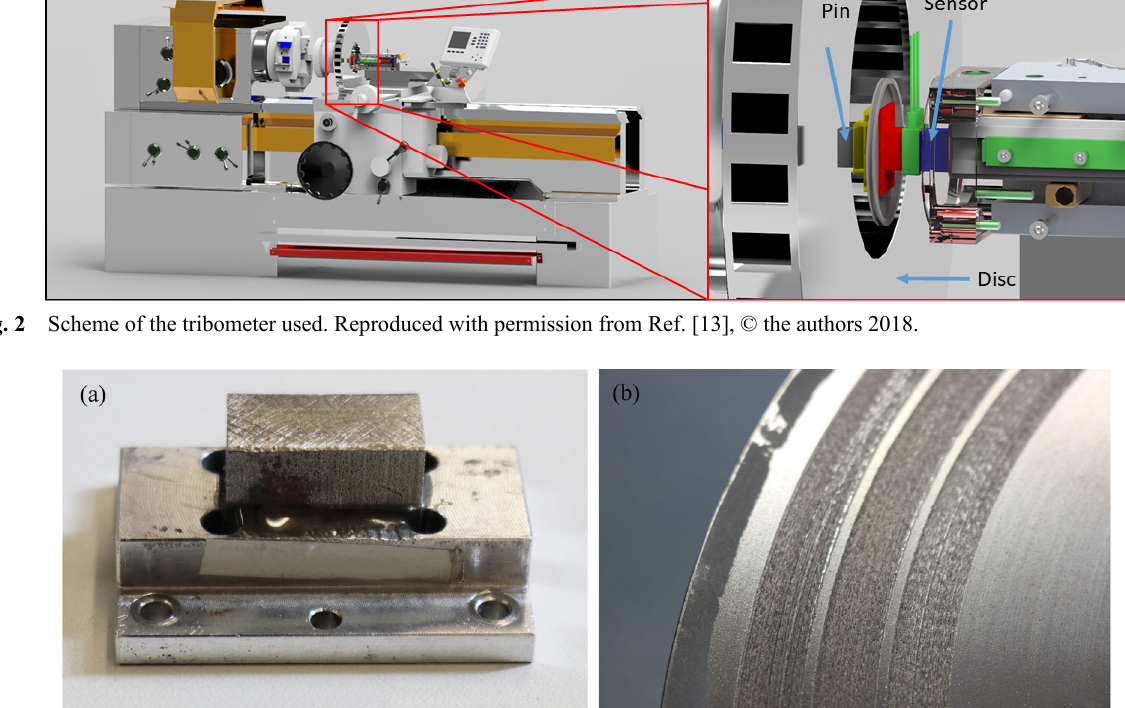
Fig. 3 Contact partners: (a) pin with sample holder and (b) disc with three friction